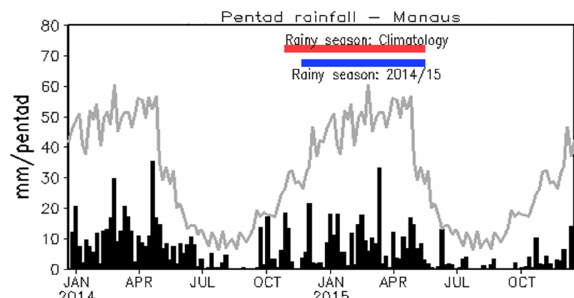
Figure 4. Pentad rainfall (mmpentad − 1 ) at Manaus (INMET site) from January 2014 to December 2015. The red bar shows the clima- tological occurrence of the onset and end of the rainy season, while the blue bar indicates the onset and end for 2014–2015. The grey line is the climatological annual cycle of pentad mean precipitation.